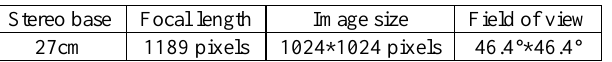
Table 2. Parameters of Yutu Navcam camera